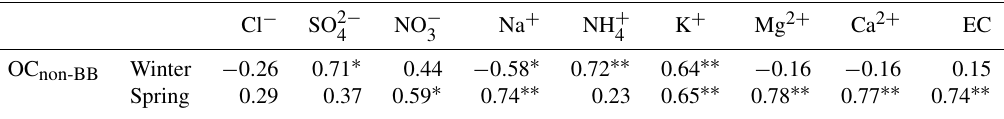
Table 4. Correlation coefficients ( r ) from a Spearman correlation analysis for OC non-BB and water-soluble ions during winter and spring of 2017 at Ulaanbaatar, Mongolia.